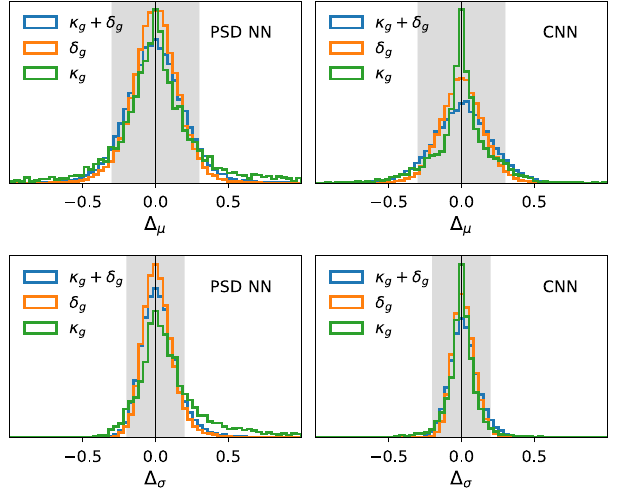
FIG. 9. Verification of the accuracy of the conditional density j θ Þ of predicted summary θ estimation of the likelihood p ð θ p t p given true parameter value θ , modeled using a mixture density t network (MDN). The upper panels show histograms of Δ μ : fractional differences between the summaries predicted by the CNN and PSD NN models θ and samples θ from the estimated p s j θ Þ , compared to the standard deviation of θ density p ð θ [see p t p Eq. (C1)]. The shaded regions correspond to < 0 . 3 σ , which is the level of error that will not have significant impact on the results. The lower panels show the fractional difference Δ σ between standard deviations of θ and θ , as defined in Eq. (C2), with p s shaded regions corresponding to < 0 . 2 σ . The histograms consist of 5700 parameter combinations from the prior space defined in Table I, concatenating all model